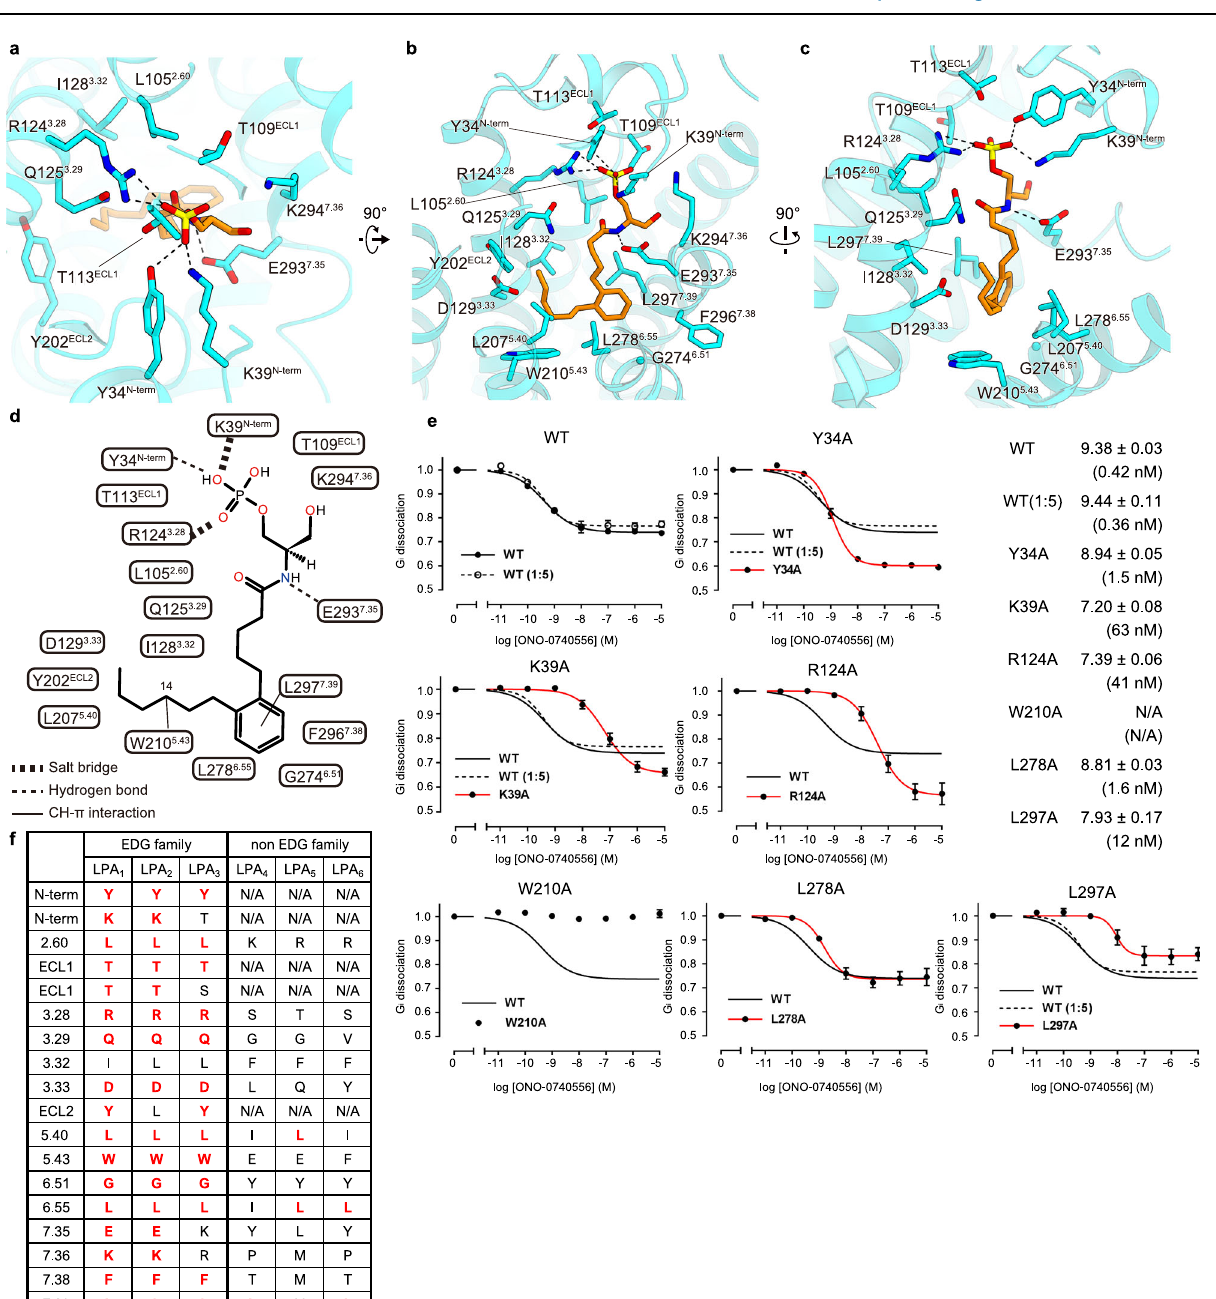
shown as means ± s.e.m. from three independent experiments. To match the expression of LPA 1 -WT to those of mutants with lower expression, 1:5